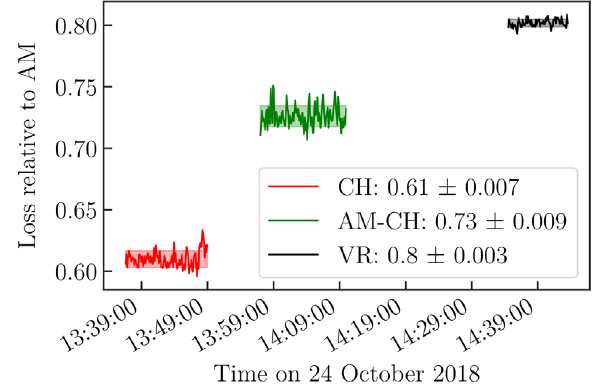
FIG. 18. Envelope of the extracted beam and channeled beamlet transported to the target and the envelope of the channeled beamlet.